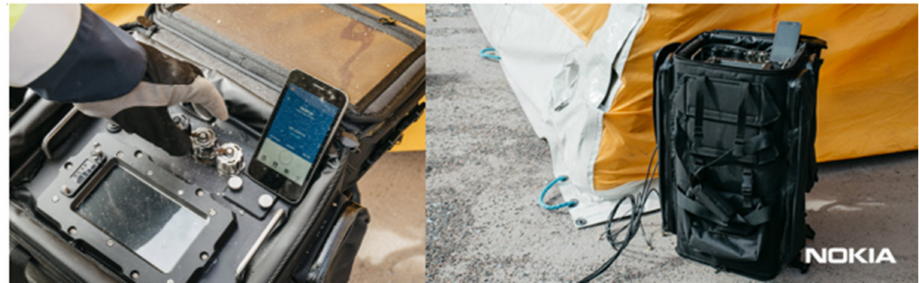
Figure 10. Bio-Garden exercise: Nokia Ultra Compact Network LTE system (LTE portable base station) tested during the